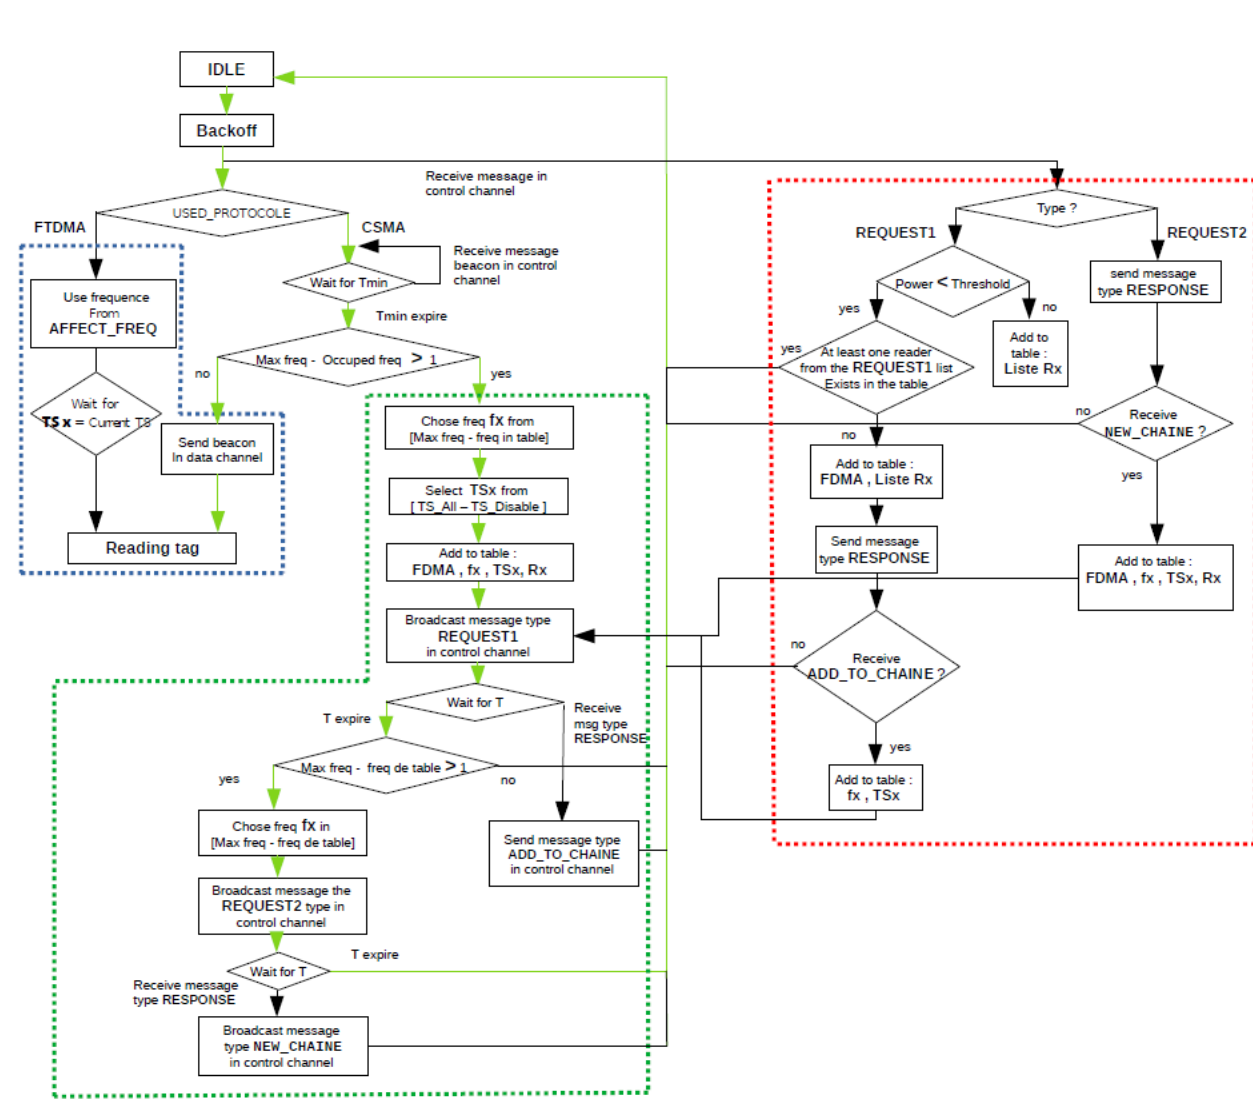
Figure A3. R3 Figure A3. R3 process.